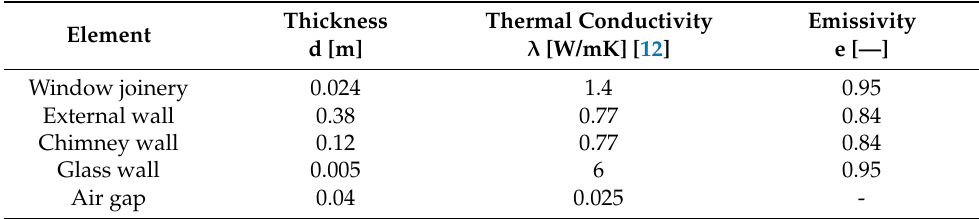
Table 2. The material and thermal parameters of the partitions in the ventilation system. Element